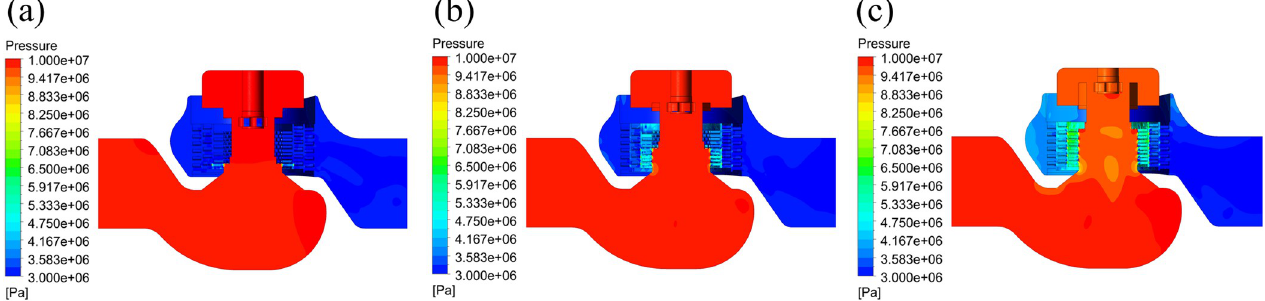
Fig 5. Pressure distributions of the flow field at different openings. (a) 10% opening. (b) 50% opening. (c) 100% opening.